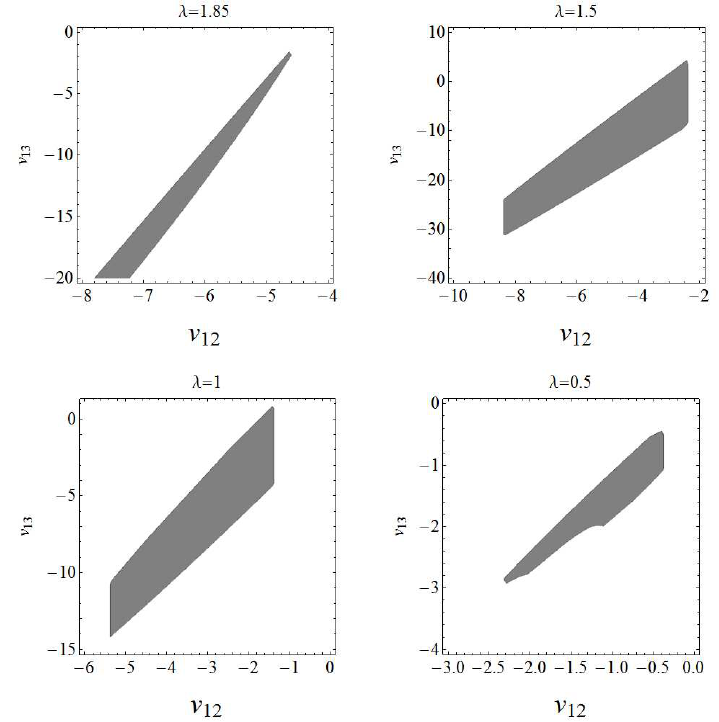
Figure 2. L -stable and A -stable methods with c = [1 / 4 , 1 / 2 , 3 / 4 , 1]